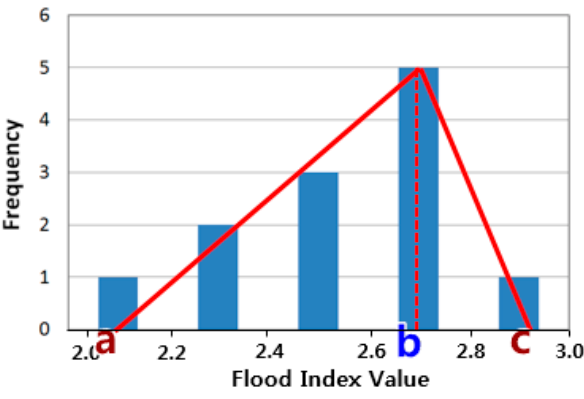
Figure 3. Distribution of the index value.